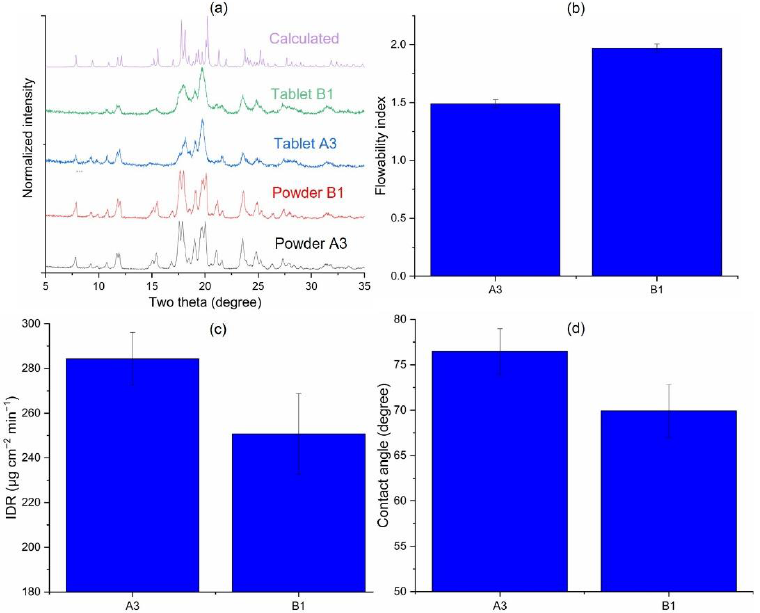
Figure 4. Solid-state characterization, bulk properties of Samples A3 and B1. ( a ) X-ray diffraction; ( b ) flowability; ( c ) intrinsic dissolution rate; ( d ) contact angle.